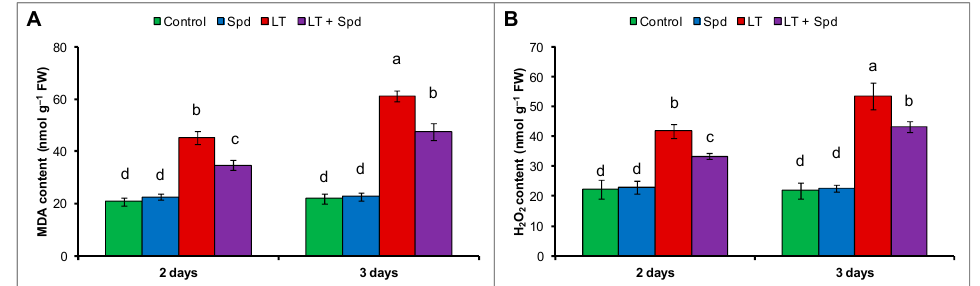
Figure 3. MDA (malondialdehyde, a product of lipid peroxidation) ( A ) and H 2 O 2 ( B ) contents in mung bean seedlings. Spd and LT indicate spermidine (0.25 mM) and low temperature (6 °C), respectively. Mean (±SD) was calculated from three replicates for each treatment. Bars with different letters are significantly different at p ≤ 0.05 applying DMRT.